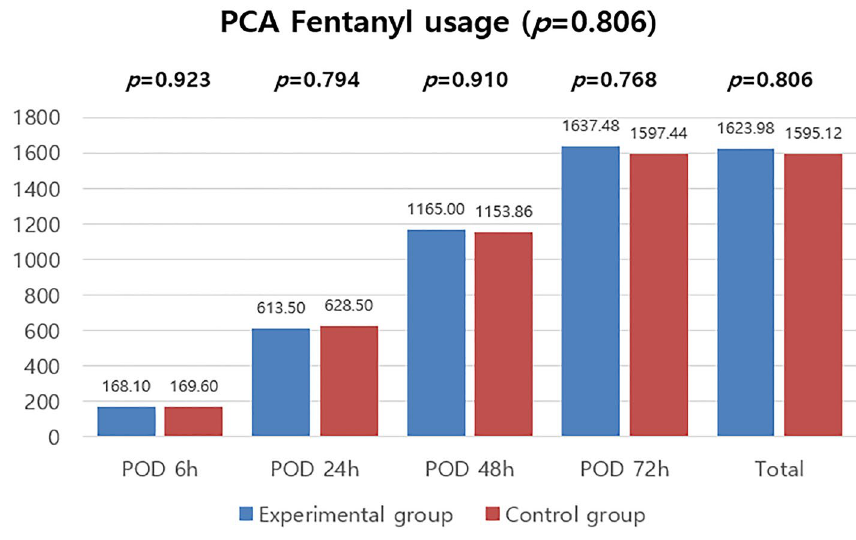
Figure 2. Amount of fentanyl consumed.